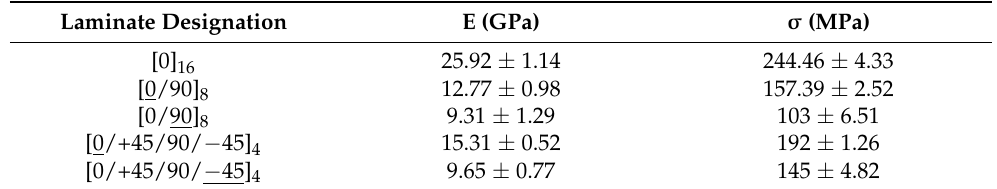
Table 1. Flexural mechanical properties of studied laminates.